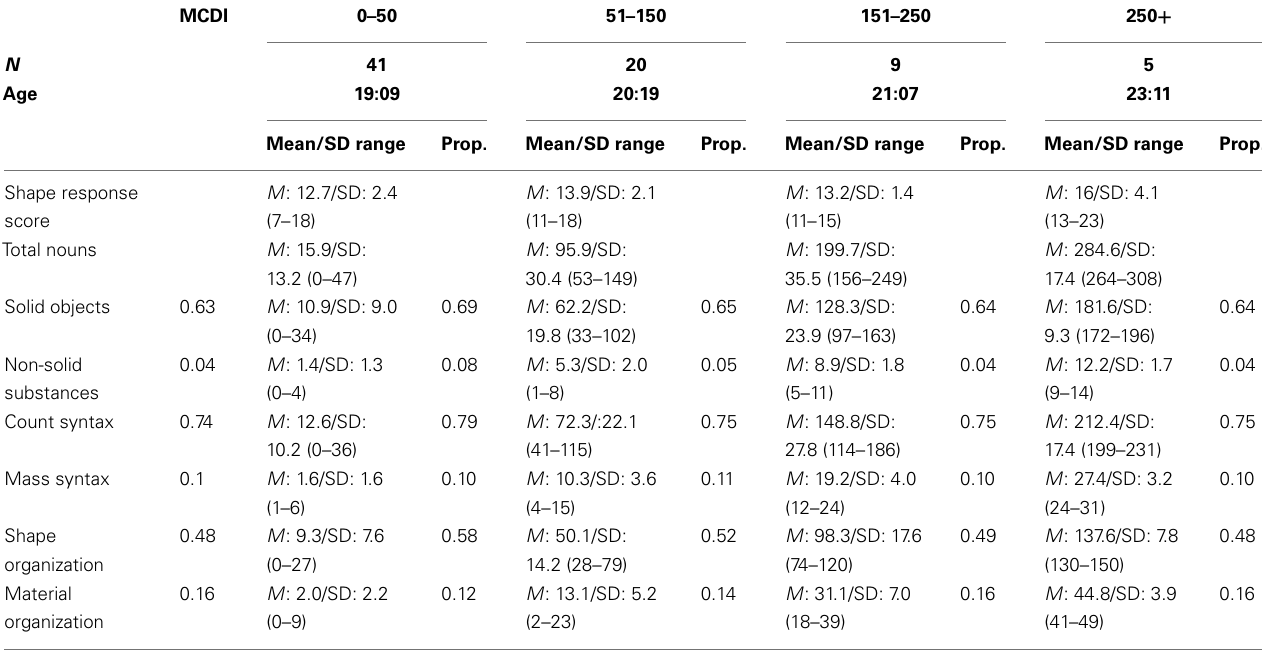
Table 1 | Proportion shape response and mean, SD, range, and proportion of nouns in each vocabulary classification for each vocabulary